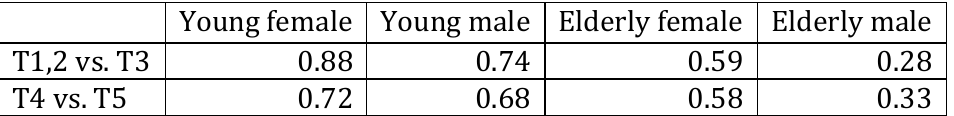
Table 1: Overall Wilk’s Lambda of the LDA model for each speaker group (lower values indicate higher